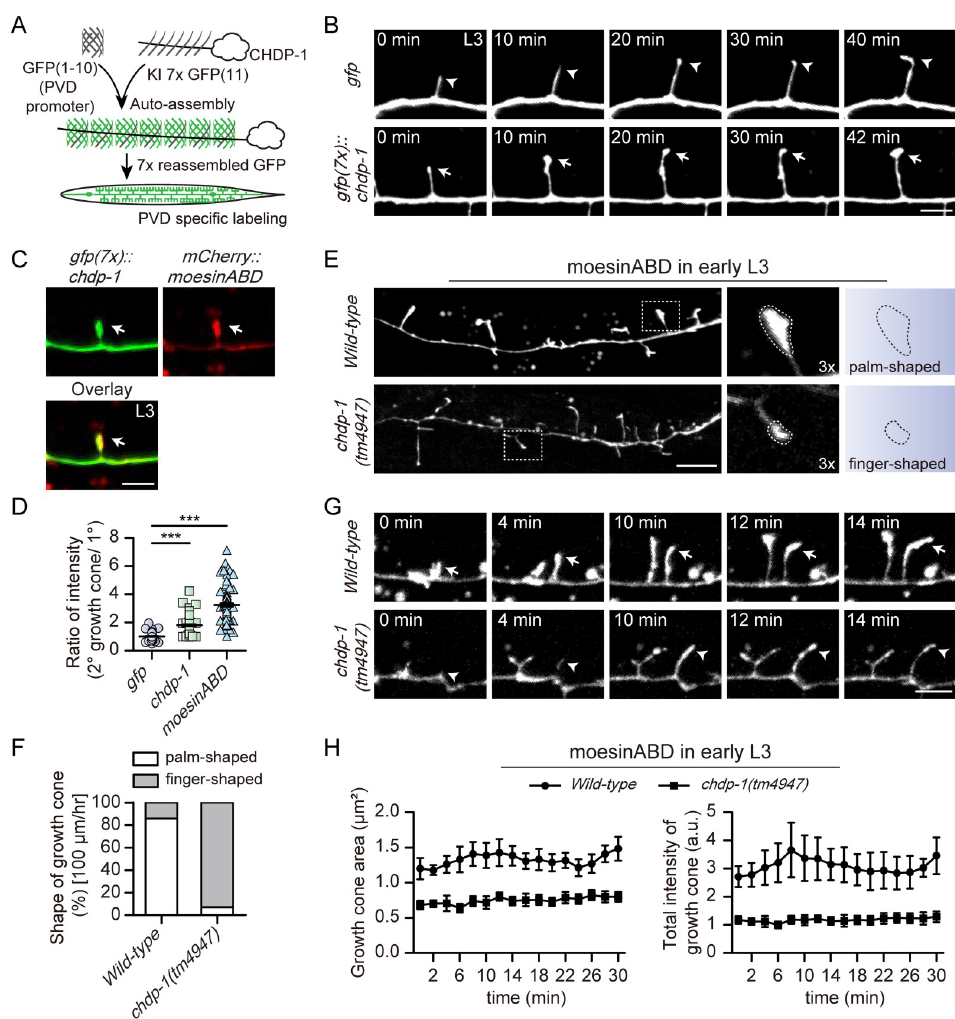
Fig 4. Loss of chdp-1 causes reduced actin assembly in the dendritic growth cones. (A) A schematic diagram illustrating how the endogenously expressed CHDP-1 protein is specifically lighten up by GFP using the native and tissue-specific fluorescence approach. (B) Confocal images from time-lapse movies of growth cones labeled by GFP (upper) and GFP(7x)::CHDP-1 (lower) at L3 stage. Arrowheads: growth cones labeled with GFP, arrows: growth cones labeled with GFP(7x)::CHDP-1. Scale bar: 5 μ m. (C) Confocal images showing the localization of GFP(7x)::CHDP-1 (left), mCherry::moesinABD (middle), and overlay (right) at early L3 stage. Arrows: growth cones. Scale bar: 5 μ m. (D) Quantification of the ratio of the GFP, CHDP-1 and moesinABD intensity of the 2 o dendrite growth cones to that of the primary branches. Error bars, SEM. ��� p < 0.001 by one-way ANOVA with the Tukey correction. n = 100 growth cones for each genotype. (E) Confocal images of GFP::moesinABD in wild-type (upper), chdp-1(tm4947) mutant (lower) at early L3 stage. Scale bar: 10 μ m. Dotted line depicts the shape of the developing growth cone. (F) Quantification of the percentage of different morphology of growth cones in wild-type and chdp-1(tm4947) mutant in a 100 μ m area anterior to the PVD cell body. n = 128 2 o growth cones (from 10 animals) for WT, and n = 227 2 o growth cones (from 10 animals) for chdp-1 mutants. (G) Confocal images from time-lapse movies of GFP::moesinABD in wild- type (upper) and chdp-1(tm4947) mutant (lower) during early L3 stage. Arrows: growth cones in wild-type , arrowheads: growth cones in chdp-1(tm4947) . Scale bar: 5 μ m. (H) Quantification of the average area of growth cones labeled by GFP::moesinABD, and the ratio of the intensity of the growth cones in the 2 o branches to that of the primary dendrite in wild-type and chdp-1(tm4947) during early L3 stage. n = 100 growth cones for each